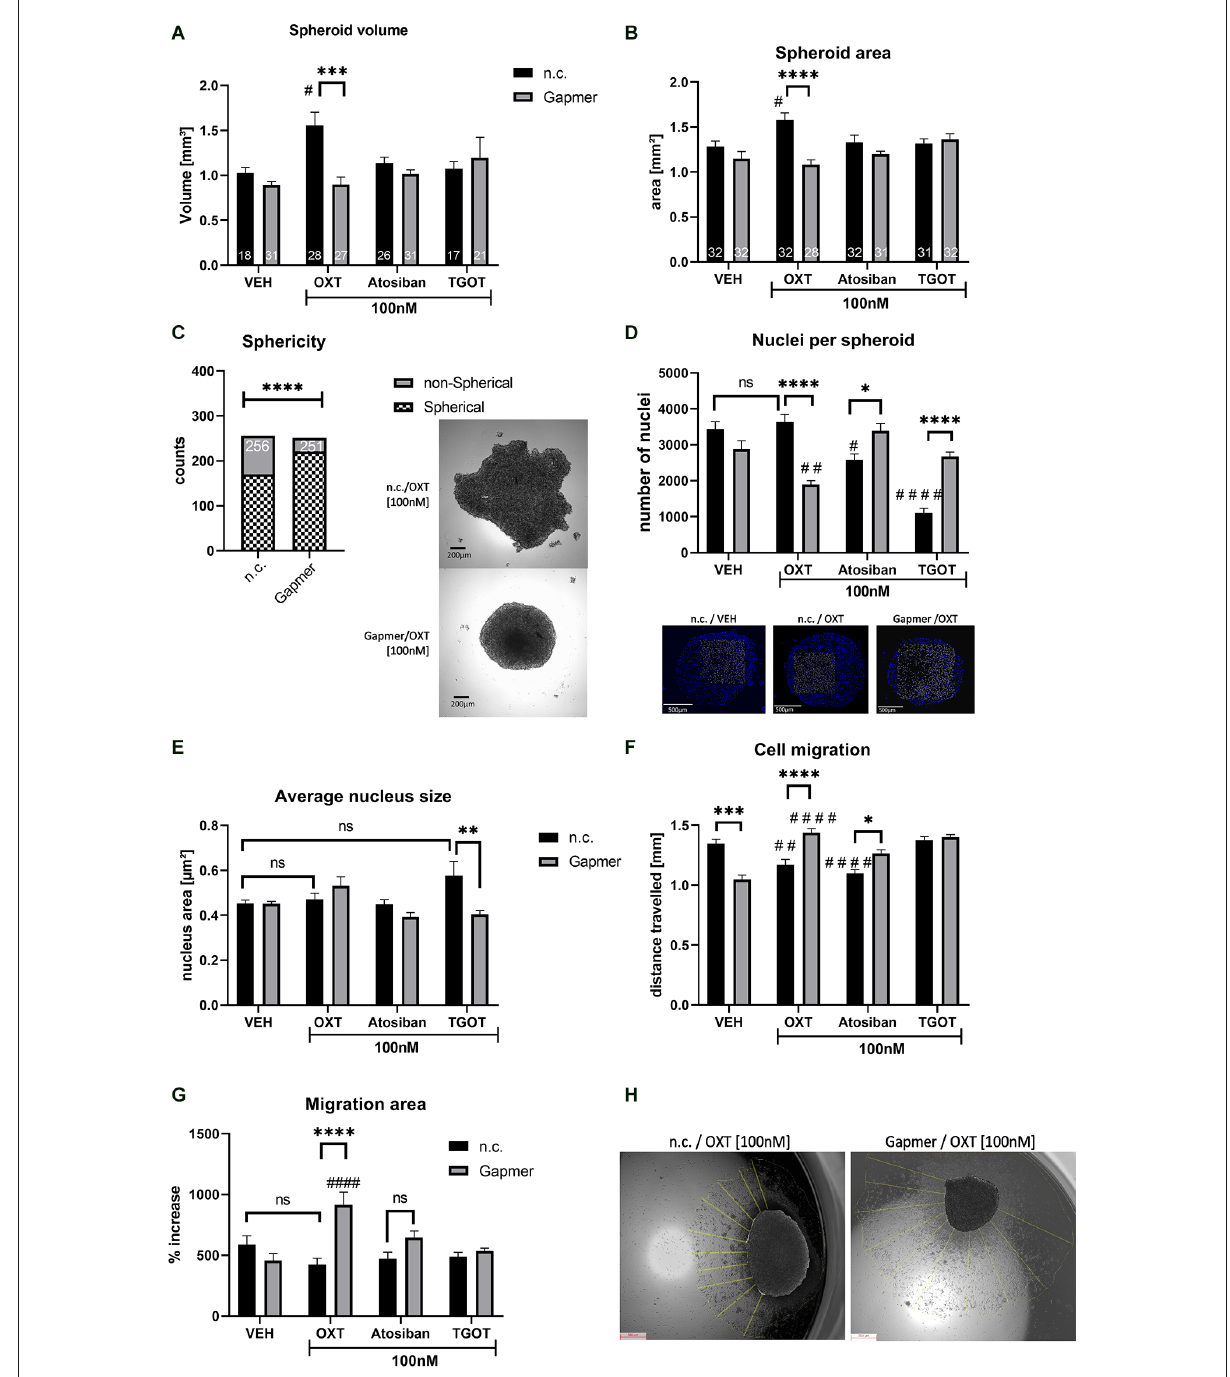
FIGURE2 Effects of OXTR truncation and ligand treatment (OXT, Atosiban, TGOT) on cells cultured 3D in spheroids. Legend for all graphs: # = significant vs. the respective VEH control; ∗ = significant vs. respective ligand treatment; data represented as mean + SEM; n.s. = not significant; n.c. = negative control Gapmer; Gapmer = OXTR-specific Gapmers inducing exon 4 skipping. (A) Spheroid volume is increased 1.5-fold by 100 nM OXT ( p = 0.0191), an effect that is reversed by Gapmer pre-treatment ( p = 0.0001). 100 nM Atosiban or 100 nM TGOT have no effect on spheroid volume (two-way ANOVA, Gapmer × Ligand treatment, significant interaction F (3,191) = 4.865, p = 0.0028, Tukey post hoc correction, only spheroids with sphere-like shape are included, resulting in = 17–31, as indicated in bars). (B) Spheroid area corroborates the validity of the spheroid volume data. 100 nM OXT increases the spheroid surface area to ∼ 1.6 mm 2 , Gapmer pre-treatment reverses this increase to basal